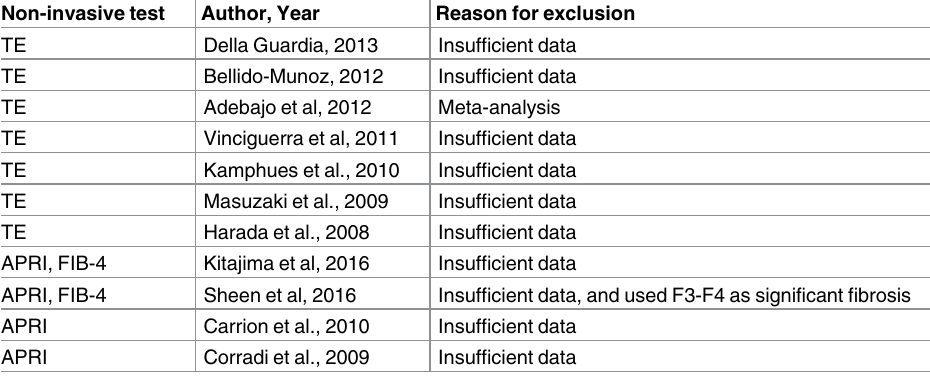
Table 1. Excluded studies and reasons for